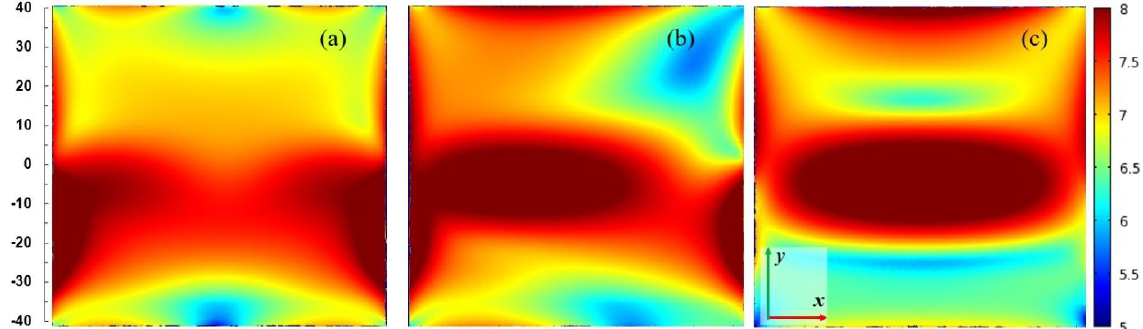
Figure 18. Dependence of powers ratio on movable plunger position for closed configuration, s = 10 and two values of the electron density. a: n e = 1 × 10 20 m −3 and b: n e = 1 × 10 21 m −3 . Calculations show that a typical stripline, when a quartz box with plasma is placed in it, begins to radiate strongly. To avoid this, the parallel ground plates must be supplemented with additional metal plates to form a metal box through which only the quartz box protrudes. With such a design, the radiation can be reduced to zero for some plunger positions. However, even with this design, radiation can be noticeable (up to 20% of the power entering) for other positions of the plunger because the plasma extends outside the box.